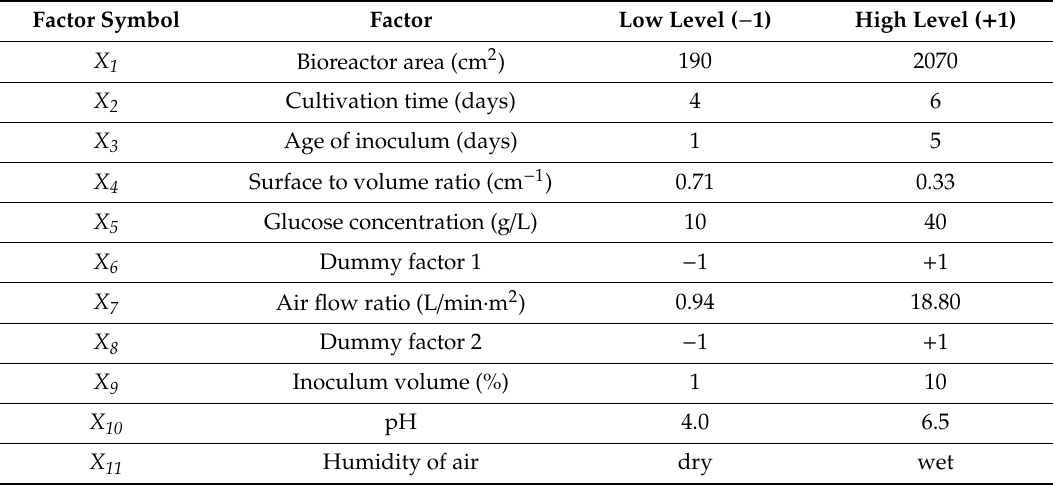
Table 1. Factors assigned at two levels in the Plackett–Burman design.